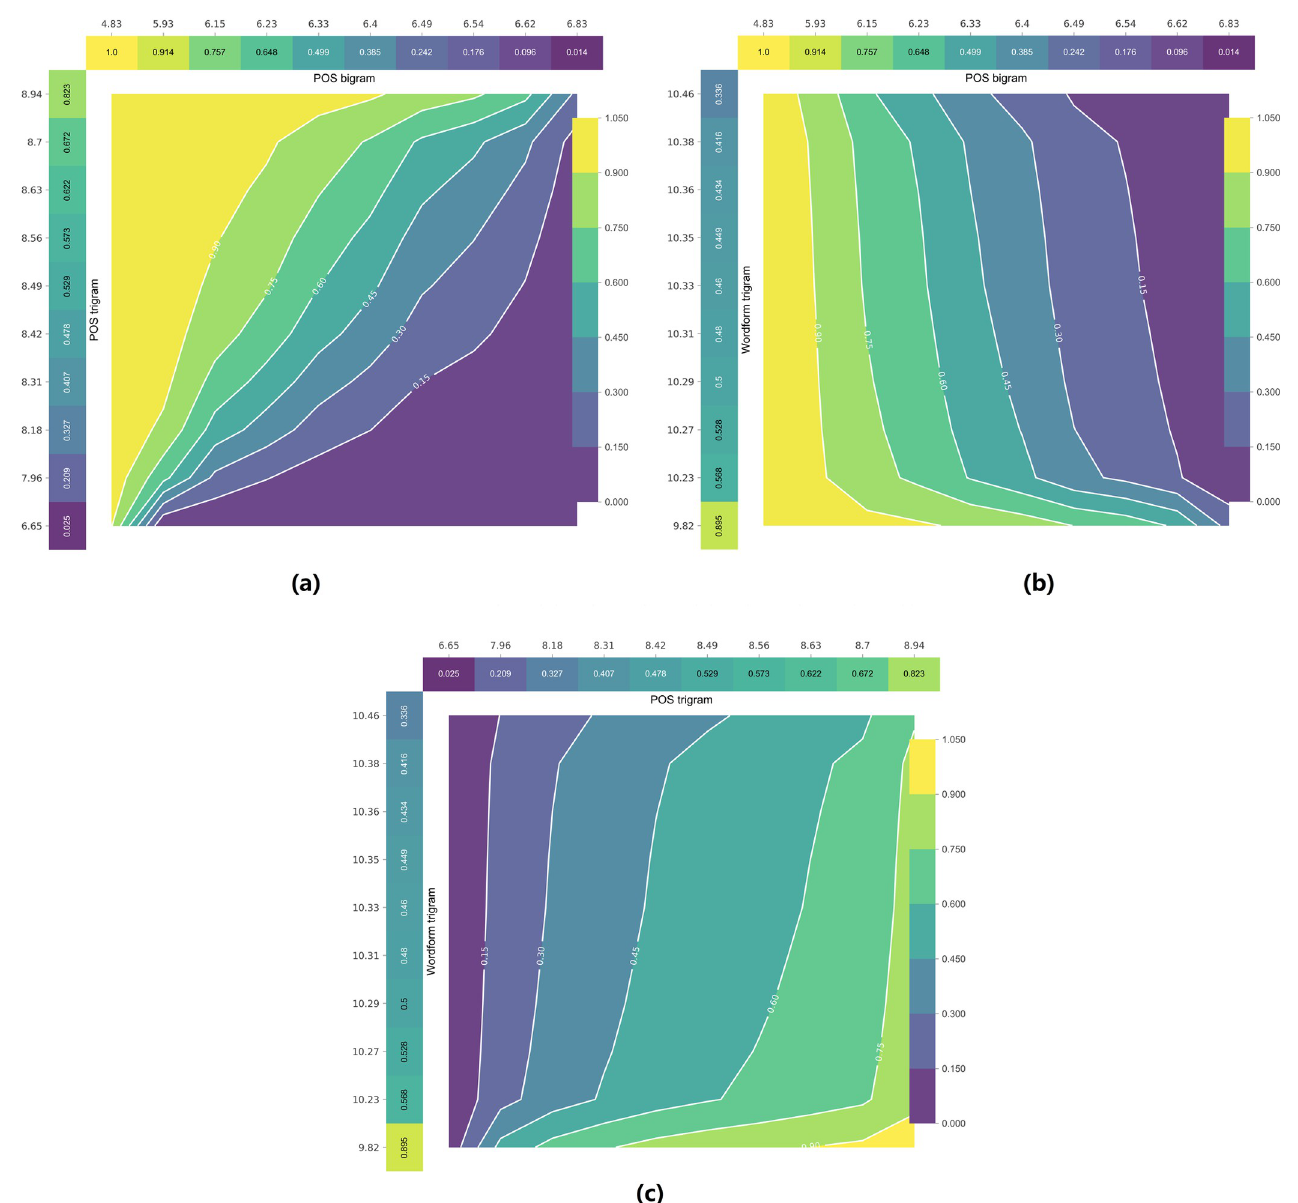
Fig 2. Two-feature Interaction effect in contour plot. (where (a) is the interaction between POS bigram POS trigram, (b) is the interaction between POS bigram and Wordform trigram, (c) is the interaction between POS trigram and Wordform